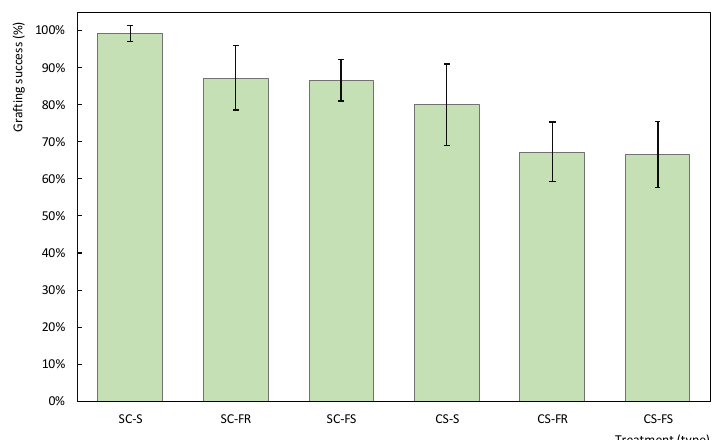
Figure 7. Grafting success for different test techniques. Success rate includes standard deviation, calculated from 6 replications. Table 1. Comparison between success averages tested for di ff erent placement orders. Grouping of the